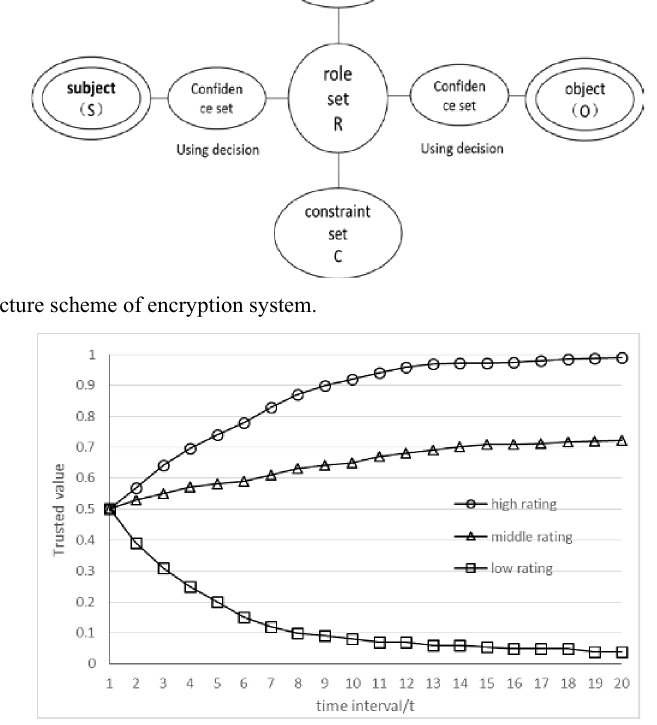
Fig. 2. The change curve of trust value of the same entity under different trusted